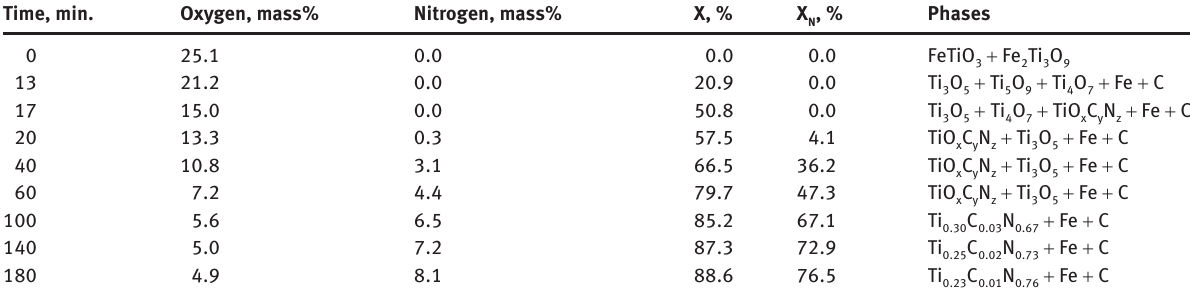
Table 4: LECO analysis and phase composition of primary ilmenite in the progress of reduction in the H 2 -N 2 gas mixture at 1373 K.